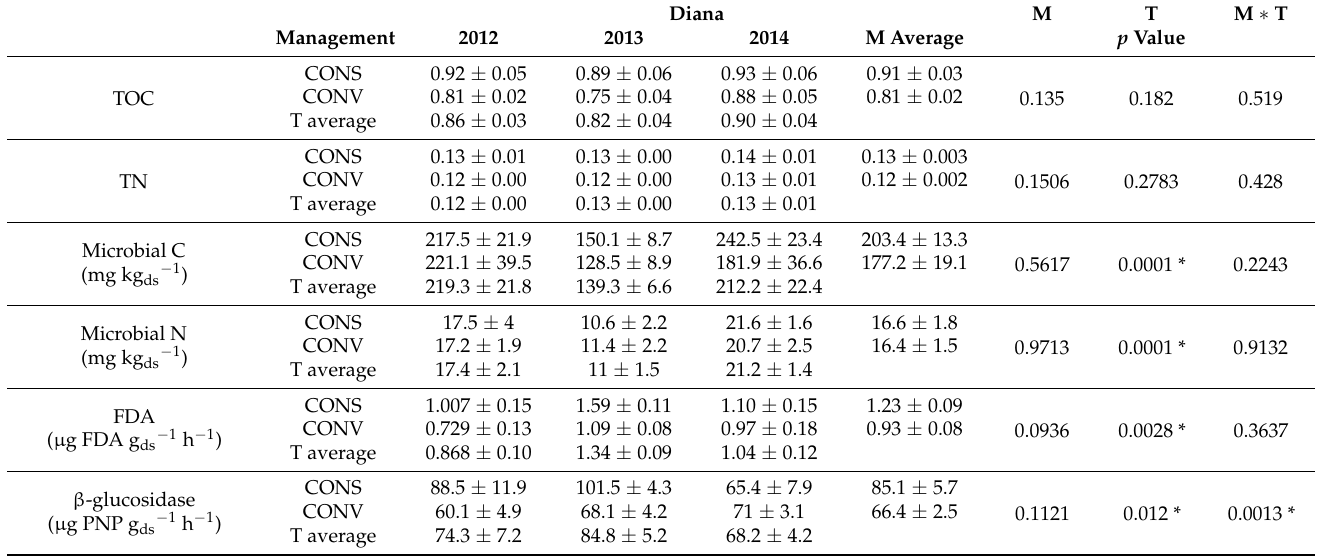
Table 3. Soil evolution in Diana